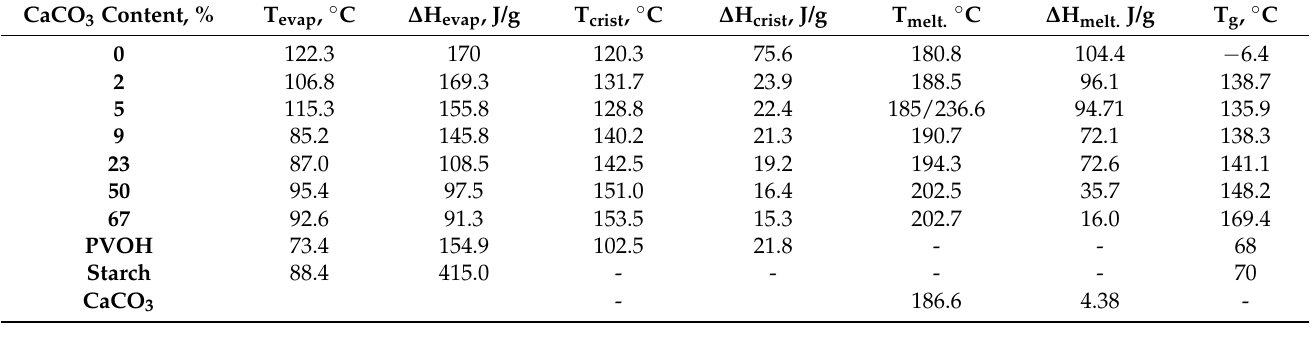
Table 4. Dependence of the thermal transitions and of the related enthalpies of the PVOH-starch compounds with variable CaCO 3 content.